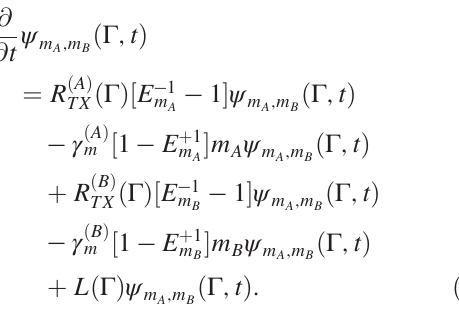
ffiffiffiffiffiffiffiffiffiffiffiffiffi p 1 − 3 q